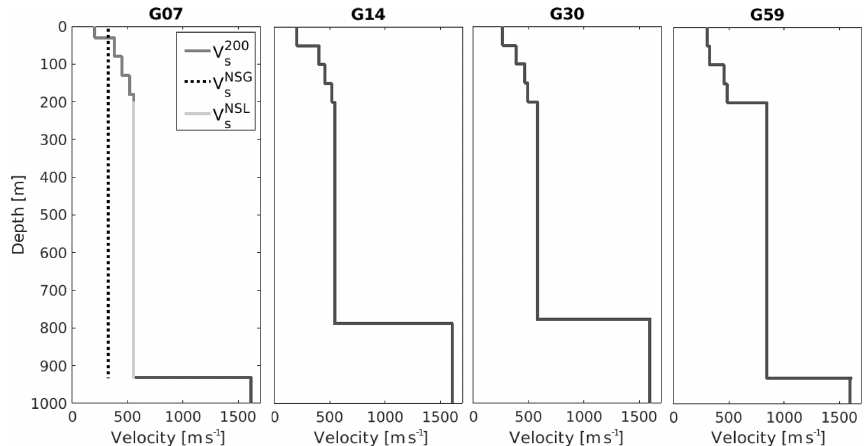
Figure 7. Final subsurface velocity profiles, respectively, for stations G07, G14, G30 and G59. The left panel shows the construction of a merged shear-wave profile: velocity profiles of the upper 200m ( V 200 s , dark grey line) are taken from Hofman et al. (2017); the entire NSG average velocity ( V NSG s , dotted line) is taken from teleseismic phases. V NSL s (light grey line) is calculated from V 200 s and V NSG s (Eq. 5). The velocity contrast at around 800m depth is between the base NSG and top Chalk